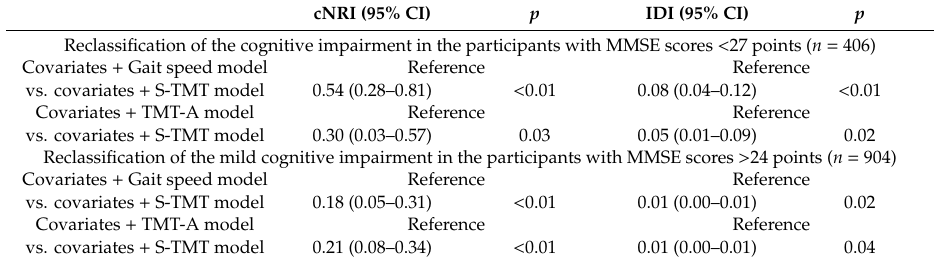
Covariates model included age, sex, years of education, body mass index, stroke, heart disease, diabetes, geriatric depression scale score, and handgrip strength. CI, confidence interval; cNRI, continuous net reclassification improvement; IDI, integrated discrimination improvement; S-TMT, Stepping Trail Making Test; TMT-A, Trail Making Test A; MMSE, Mini-Mental State